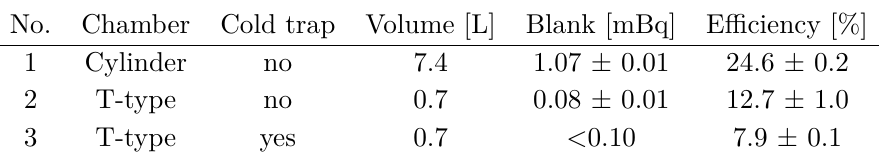
Table 5. Performance of radon emanation measurement systems.